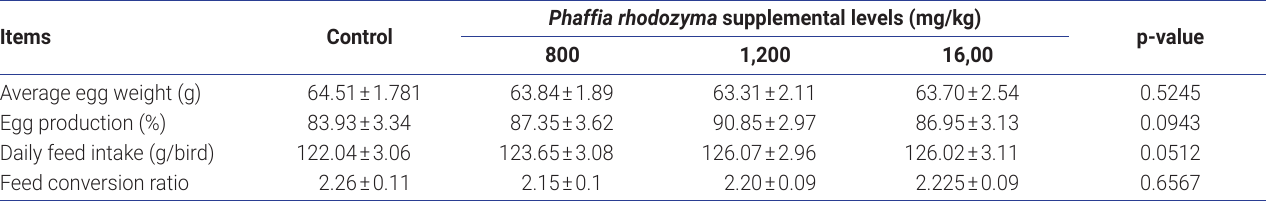
Table 2. Effect of dietary astaxanthin rich Phaffia rhodozyma levels on production performance of laying hens after 6 weeks of feeding Items